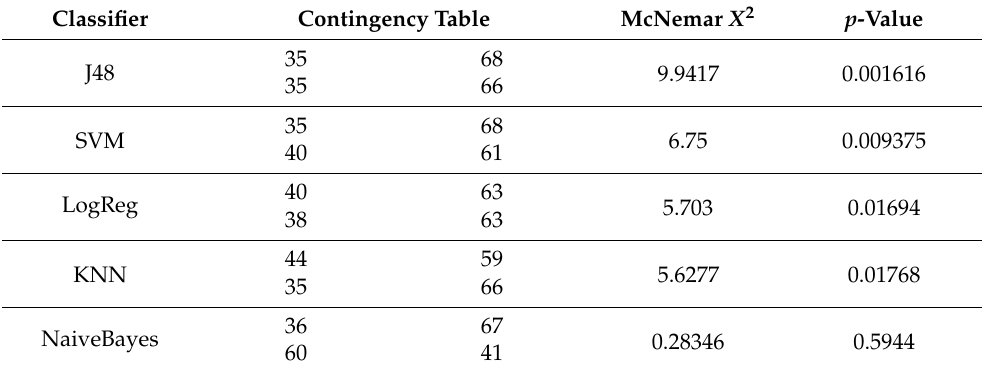
Table 8. Results of the McNemar test for comparison of used classification algorithms with base- line classification in the majority class.